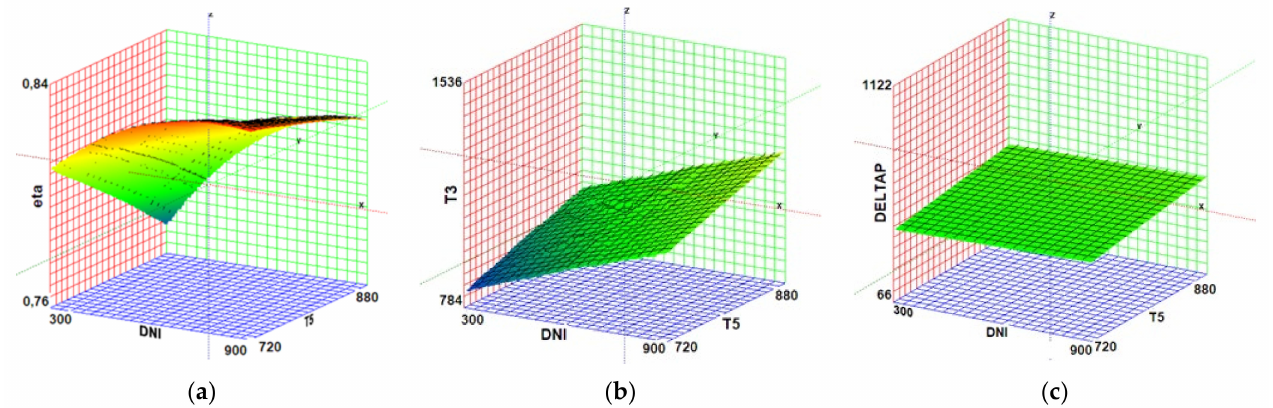
Figure 4. Receiver performance maps at a constant mass flow rate of 0.3 kg/s: ( a ) receiver thermal efficiency vs. Direct Normal Irradiance (DNI) [W/m 2 ] and receiver inlet temperature [K]; ( b ) receiver outlet temperature vs. DNI [W/m 2 ] and receiver inlet temperature [K]; ( c ) receiver pressure drops [Pa] vs. DNI and receiver inlet temperature [K] (derived from draft data from KTH, oral